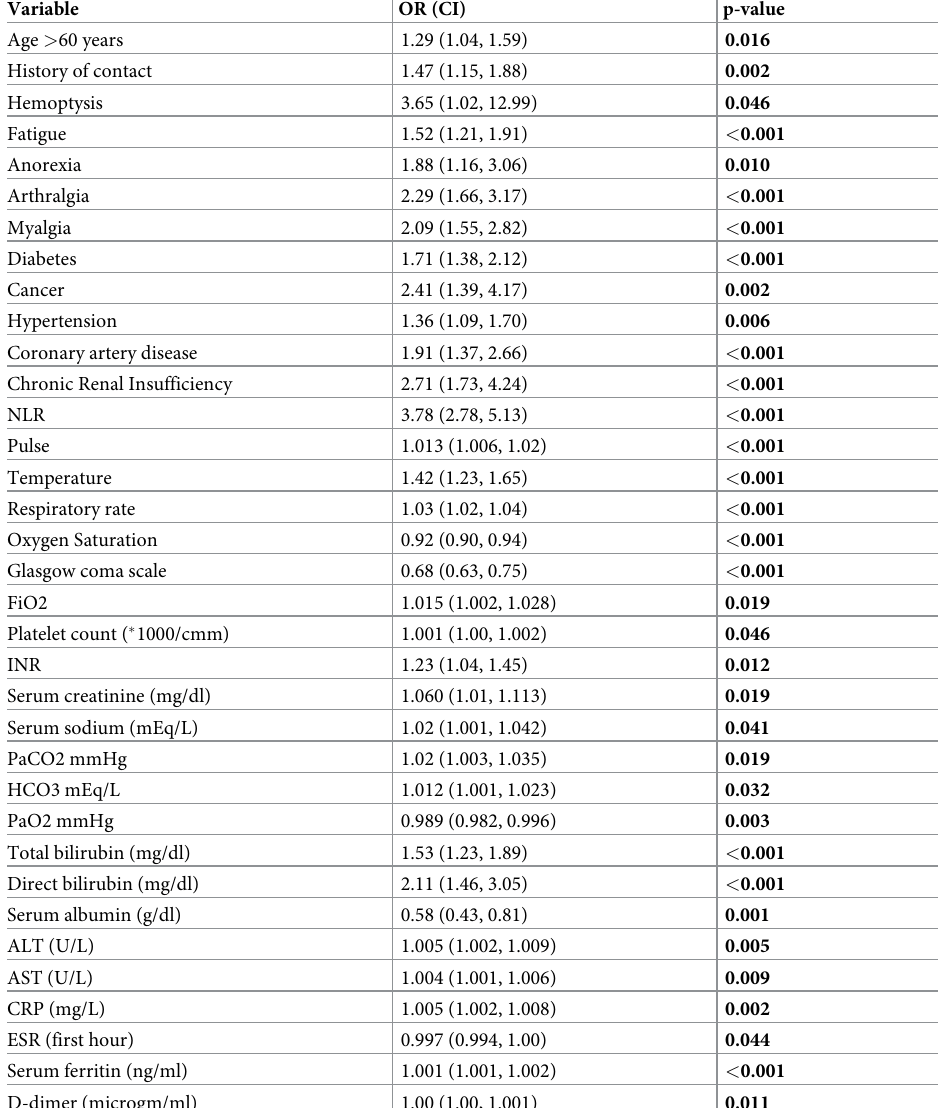
Table 3. Univariate regression of risk